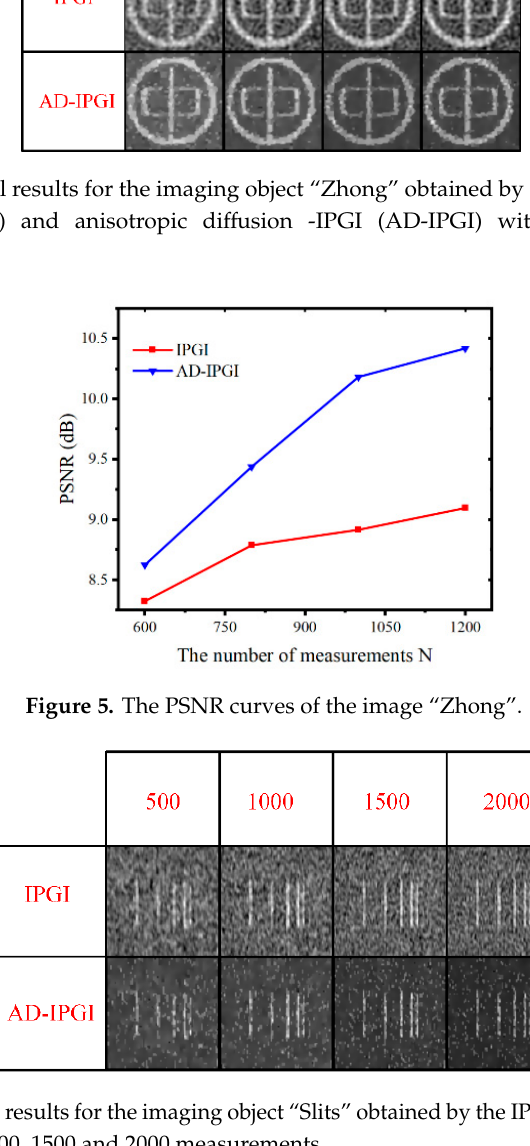
Figure 7. The PSNR curves of the image “Slits”. To explain why we choose anisotropic diffusion instead of other filtering methods, the common filtering methods median filter, mean filter and Gaussian filter are combined with IPGI separately to smooth the images used to construct the noise interference term before each iterative operation in the third set of experiments. These three methods are respectively abbreviated as Mean-IPGI, Median- IPGI and Gaussian-IPGI. The experimental results are shown in Figures 8 and 9. Compared with IPGI, the reconstruction results of these four methods are improved to various degrees, which again proves the importance of image denoising before each iteration. As Figures 8 and 9 show, Mean-IPGI can partially filter the background noise, but at the same time, it makes the image details blurred. Median-IPGI can protect the sharp edges of the image, but the denoising effect is poor. Compared with Mean-IPGI and Median-IPGI, the reconstruction quality of Gaussian-IPGI is much better and the details are well preserved. However, there is always a gap between the Gaussian-IPGI and AD- IPGI on denoising capability. Moreover, the three methods above are only applicable to certain types of noise, while anisotropic diffusion has a more general usability. The PSNR curves in Figure 8 are consistent with the analysis of visual effect. Figure 8. Experimental results for the imaging object “Slits” obtained by the mean filter -IPGI, median filter -IPGI, Gaussian filter -IPGI and AD-IPGI with 2000 measurements: ( a ) mean filter -IPGI, ( b ) median filter -IPGI, ( c ) Gaussian filter -IPGI, and ( d ) AD-IPGI.